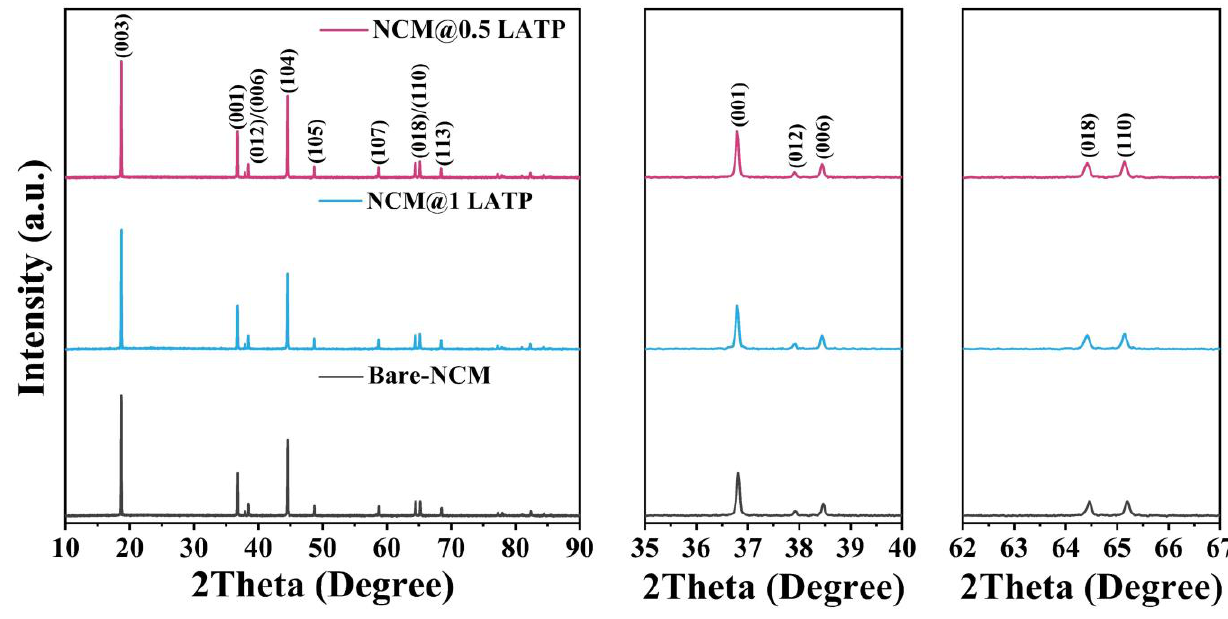
Figure 2. XRD patterns of bare NCM, NCM@0.5LATP, and NCM@1LATP.